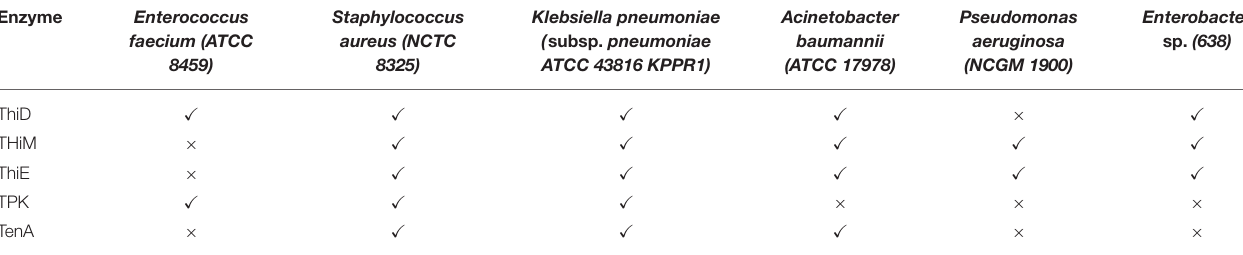
TABLE 1 | Panel of observed enzymes for the thiamine pathway in ESKAPE